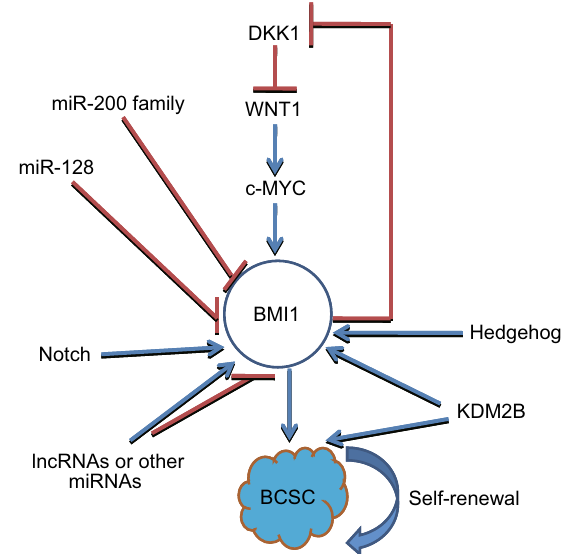
Figure 2. BMI1 regulates BCSC. BMI1 is activated by Hedgehog, Notch and Wnt pathway, and it is inactivated by miR-200 family and miR-128. There may be some other microRNAs and lncRNAs regulated